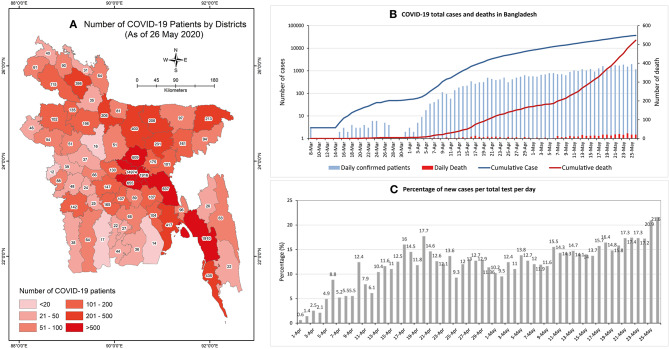
(A) Map of the study area showing the number of COVID-19 confirmed patients in the 64 districts of Bangladesh. (B) Daily confirmed COVID-19 patients and death count. (C) Percentage of new cases per total test per day (Data source: IEDCR).